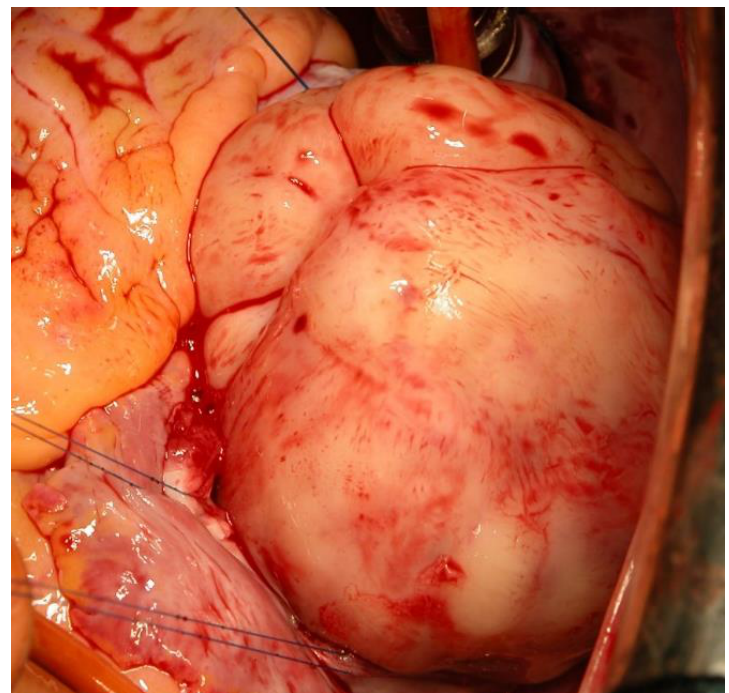
Figure 4. Intraoperative exploration of a CM via the right atrium.